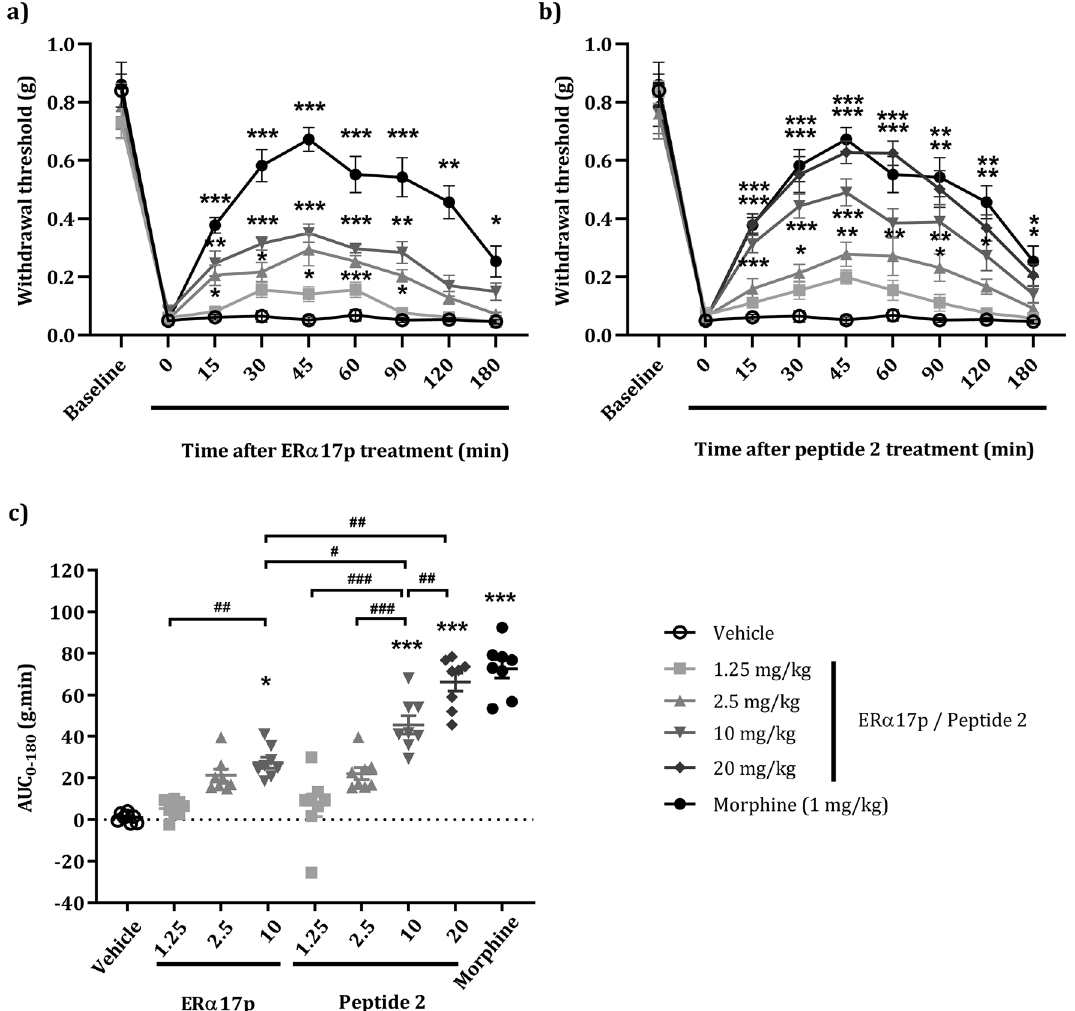
Figure 7. Effects of ERα17p and peptide 2 on tactile hypersensitivity in the murine CFA model by von Frey test. 50% paw withdrawal threshold (PWT) is determined using an adaptation of the Dixon up–down method. Seven days after CFA injection, anti-hyperalgesic actions of ( a ) ERα17p and ( b ) peptide 2 are evaluated by measuring dose-dependent effects. Von Frey test is assessed before CFA injection (baseline) and after vehicle injection (saline solution, control), ERα17p (1.25, 2.5 and 10 mg/kg), peptide 2 (1.25, 2.5, 10 and 20 mg/kg) or morphine (1 mg/kg, reference) treatments (i.p 10 mL/kg). The nine treatments of each experimental series (n = 8 mice per condition) are done in the same frame. Each treatment corresponds to a time-course curve. ( c ) Area under the time-course (0–180 min) of PWT variations from ( a ) and ( b ). Data are shown as mean ± SEM (n = 8 per group). * p < 0.05, ** p < 0.01, *** p < 0.001, compared with the vehicle group; # p < 0.05, ## p < 0.01, ### p < 0.001;